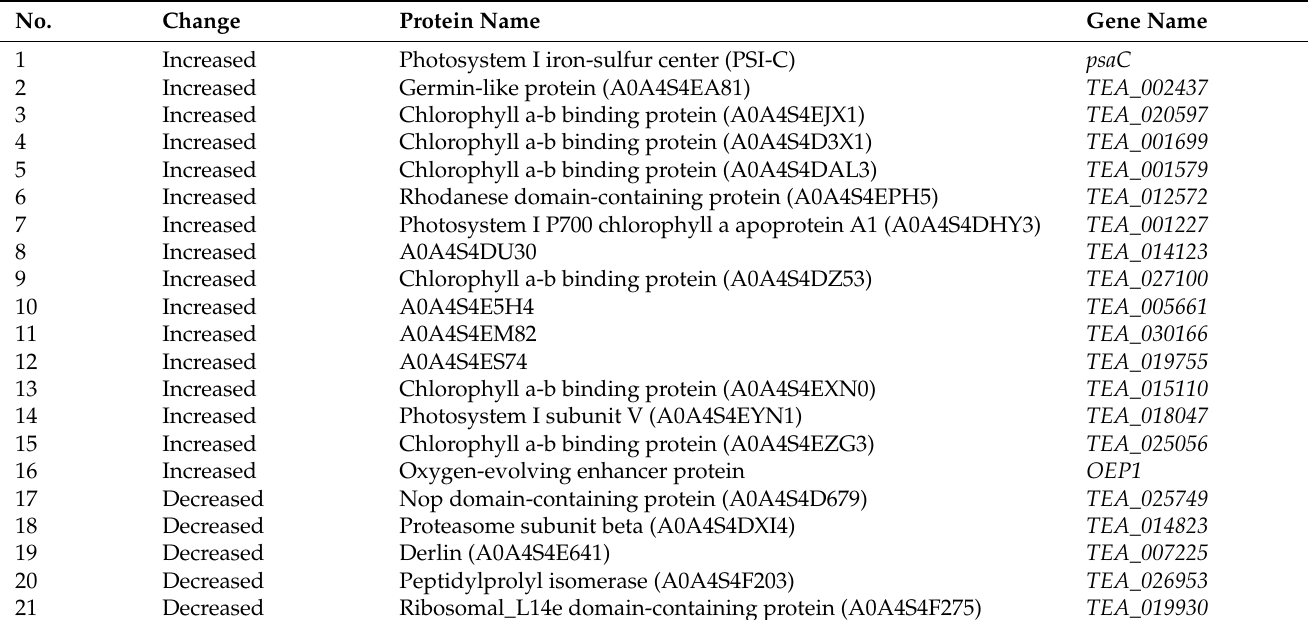
Table 2. Detected differential proteins of purple-red cultivars compared with white-yellow cultivars with protein and gene names. Increased change refers to upregulated proteins, and decreased change refers to downregulated proteins.